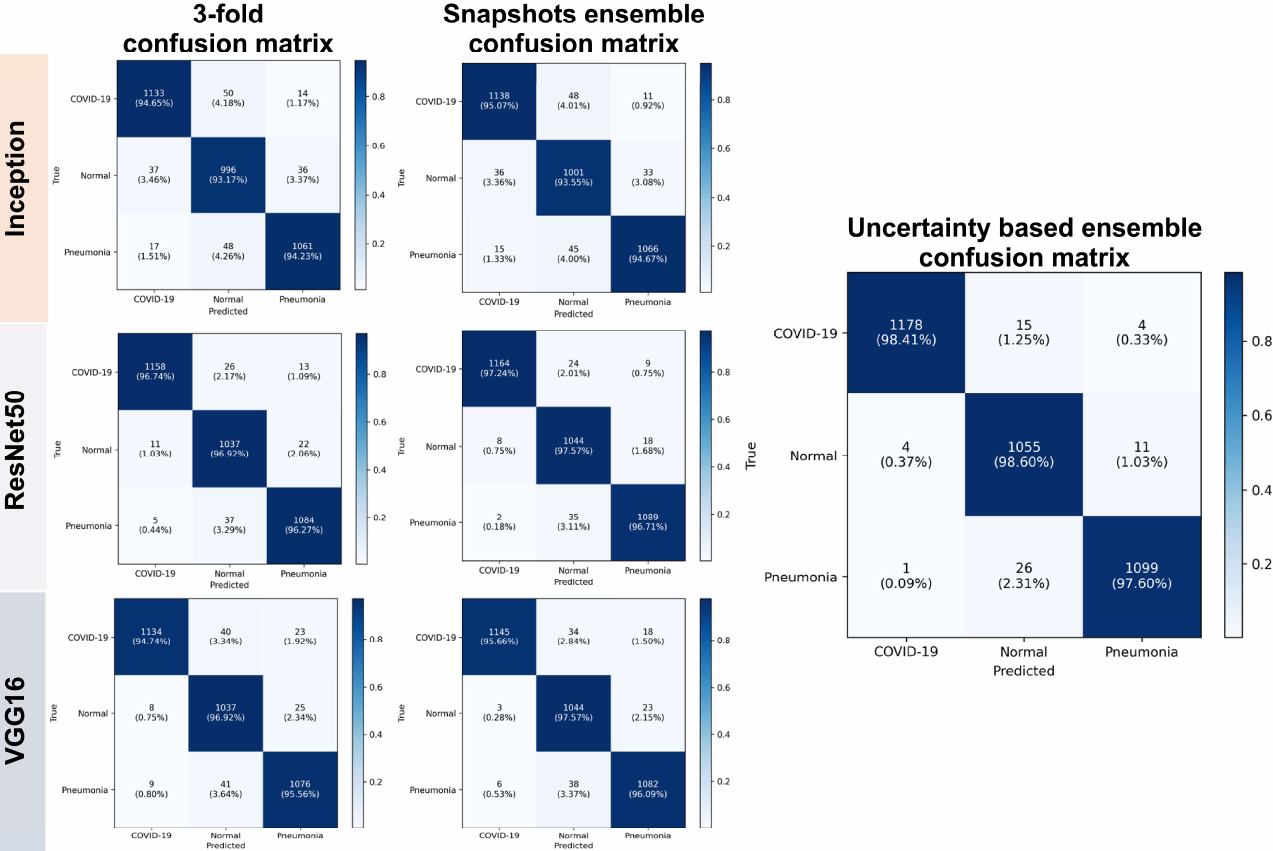
Figure 4. Proposed network performance output on unseen